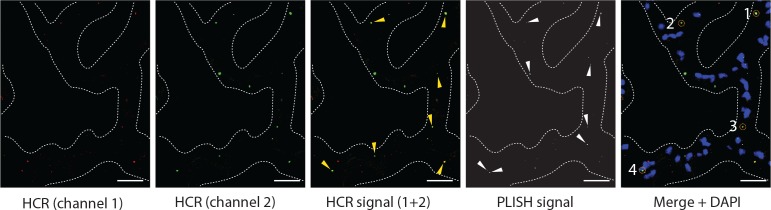
Estimating efficiency of PLISH probes in tissue.Double in situ hybridization for Axin2 using HCR and PLISH was performed in mouse lung. HCR signals (yellow arrowheads, third panel) were identified based on overlap of puncta from two different HCR channels, and PLISH puncta were imaged in the same field (white arrowheads, fourth panel). Colocalized HCR and PLISH puncta are enumerated (dashed orange circles) in the fifth panel. Over three fields of view, we observed 92 HCR puncta and 140 PLISH puncta, with 29 cases of co-localized HCR and PLISH signal. Thus, the four PLISH probe pairs gave a combined detection efficiency of 32%, with a per-site efficiency of 9%. Dashed line demarcates alveolar septae. Scale bar, 40 μm.